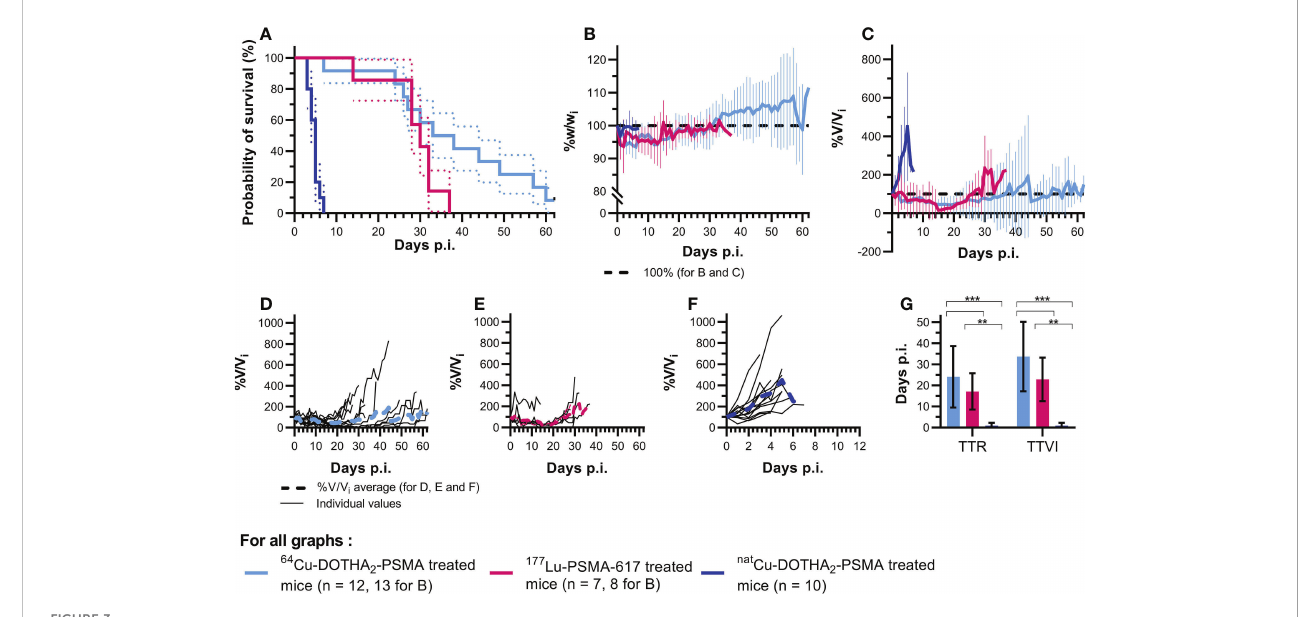
FIGURE 3 Survival assays results (A) Kaplan-Meier survival curves with signi fi cantly longer survival with 64 Cu-DOTHA 2 -PSMA than with nat Cu-DOTHA 2 -PSMA (p < 0.001, hazard ratio: 0.208 (95%CI: 0.0646 – 0.670) and no signi fi cant difference between 64 Cu-DOTHA 2 -PSMA and 177 Lu-PSMA-617 (p = 0.09, hazard ratio: 0.490 (95%CI: 0.165 – 1.45)), (B) Average weight evolution per group, (C) Average tumor size per group, (D-F) Individual tumor size for 64 Cu- DOTHA 2 -PSMA, 177 Lu-PSMA-617 and nat Cu-DOTHA 2 -PSMA treated mice, respectively, (G) Time-to-regrowth (TTR) per group, (H) Time to initial volume (TTIV) per group. (V: tumoral volume, V i : initial tumoral volume. **p < 0.01, ***p < 0.001. Errors bars are standard errors for (A) and standard deviations for B , C and G